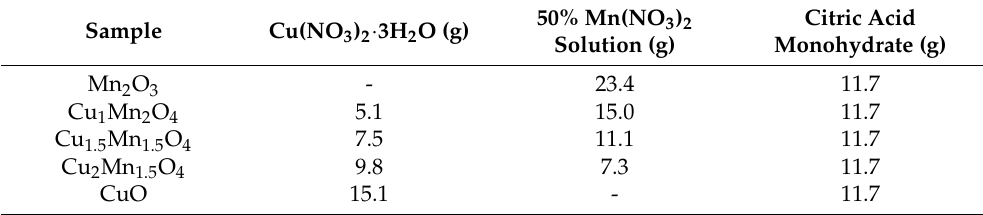
Table 3. The chemicals and their amounts used for preparing samples.